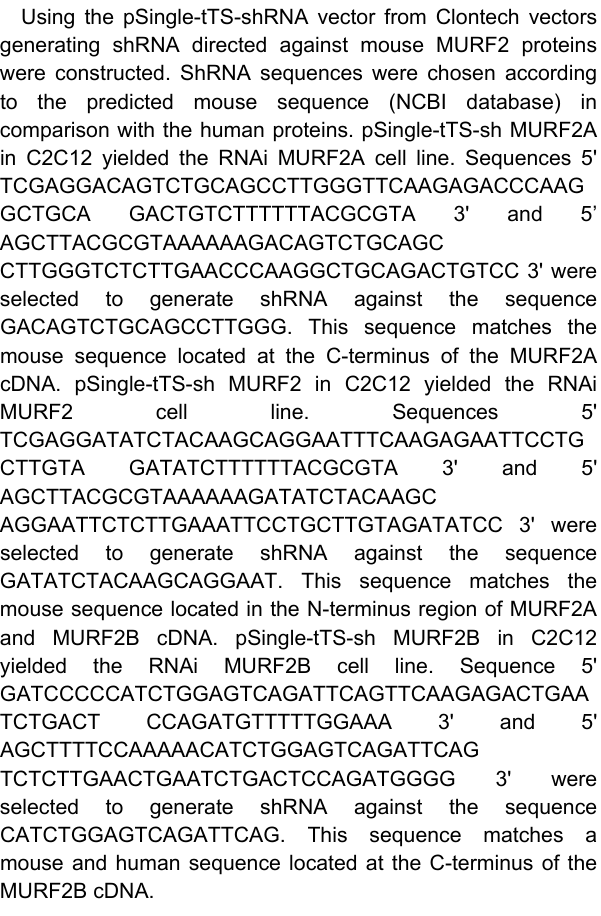
Figure S1. Analysis of MURF2 antibody specificity. (A)